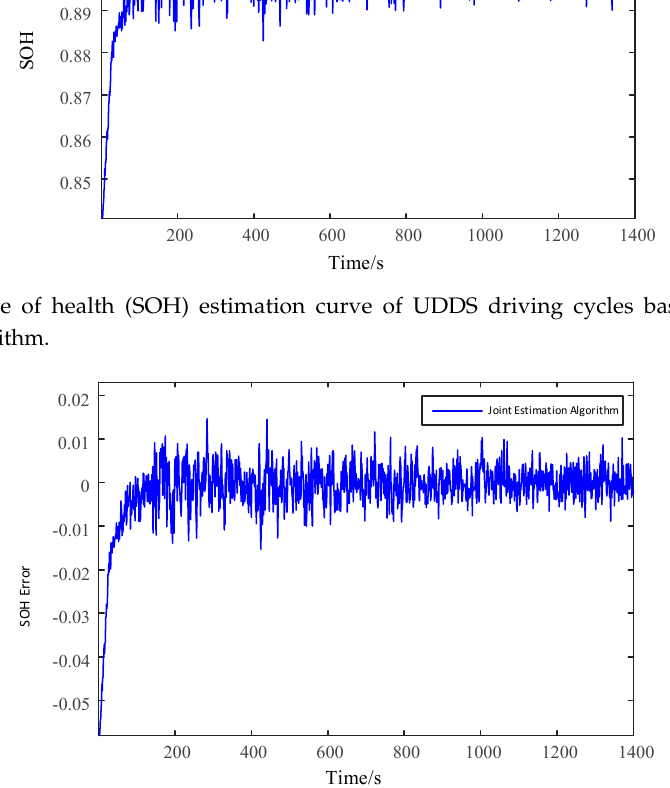
Figure 15. SOH estimation error curve of UDDS driving cycles based on the joint estimation algorithm.